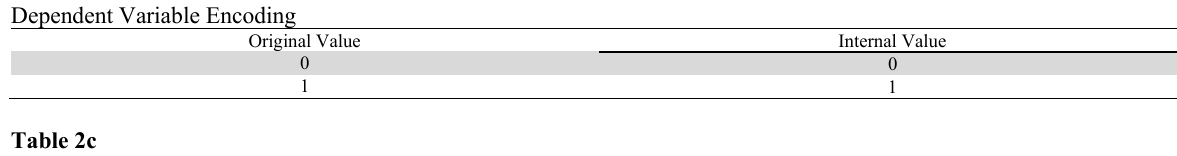
Categorical Variables Codings